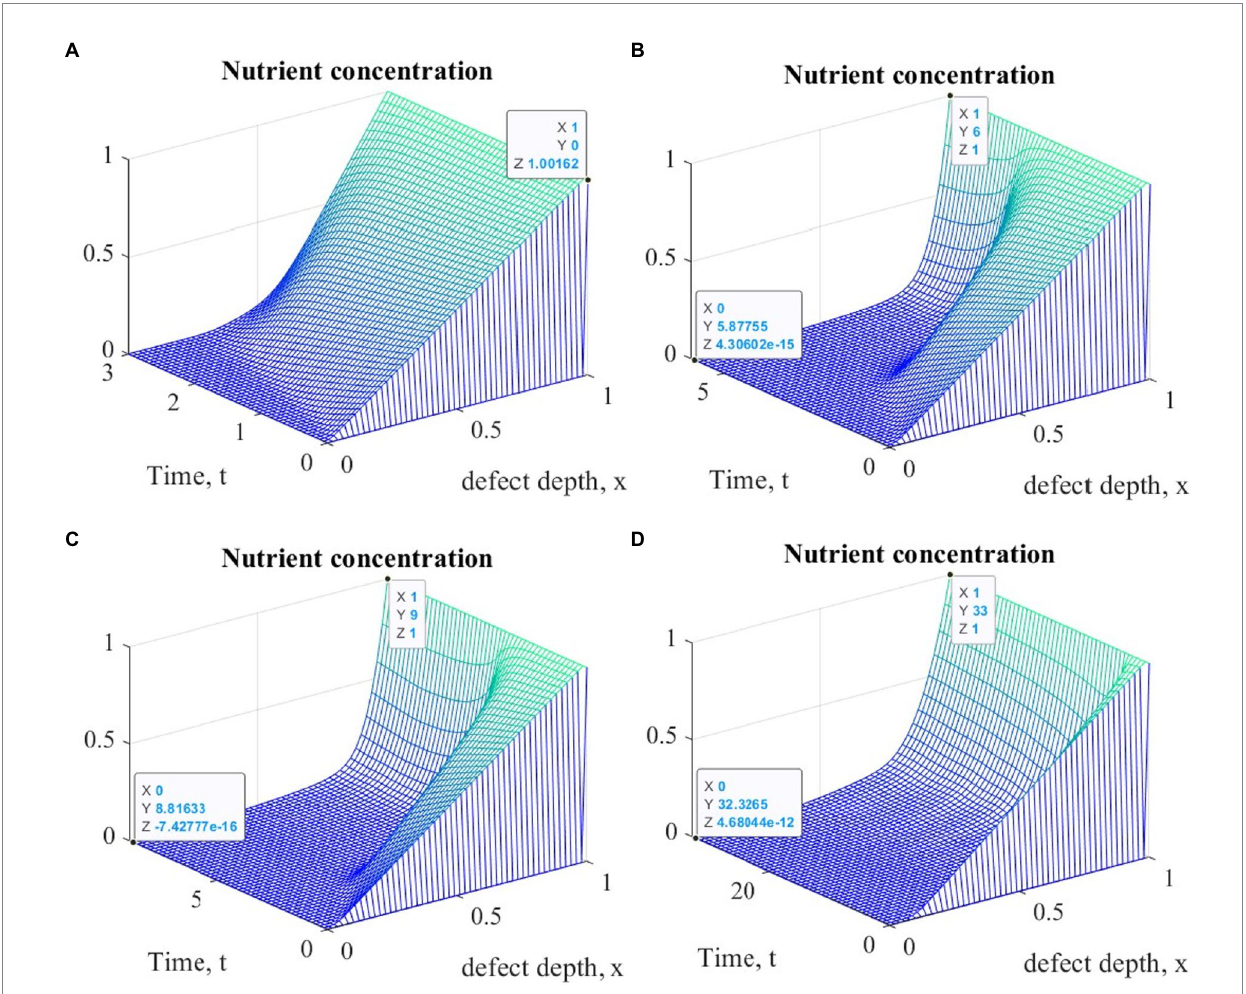
FIGURE 7 Graphs of changes in nutrient concentration at different points in time during the implementation of ACIT with mechanical stimulation with a time delay